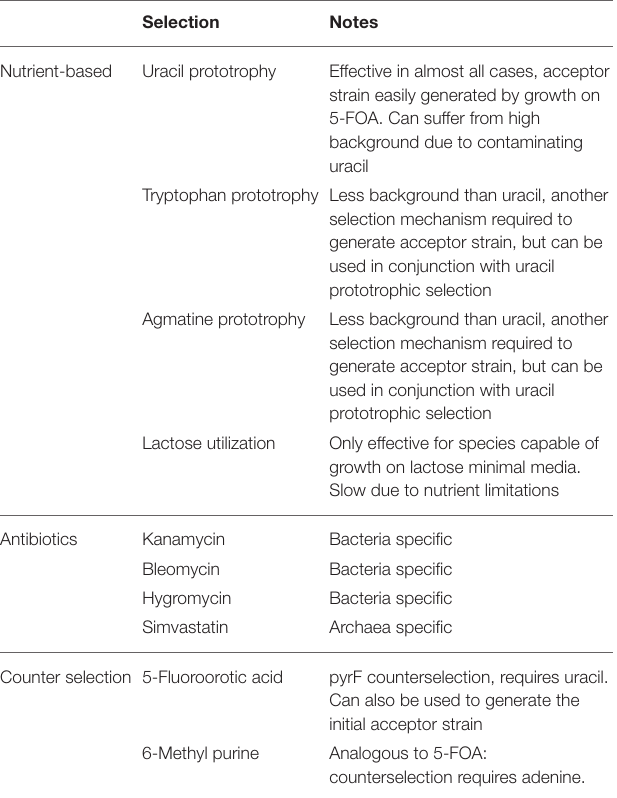
TABLE 1 | Selective pressures for genetic manipulations in extreme thermophiles.